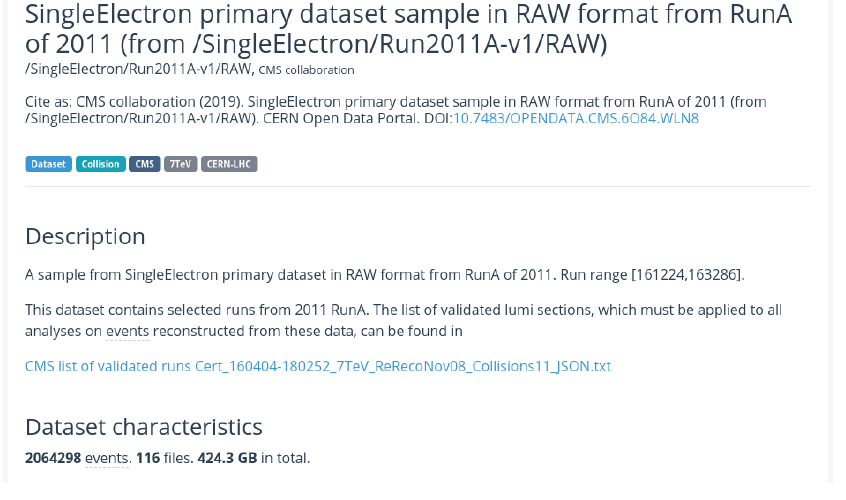
Figure 4. Example of a RAW data sample available on the CERN Open Data portal. This sample corresponds with the reconstructed AOD dataset that is shown in Figure 5.